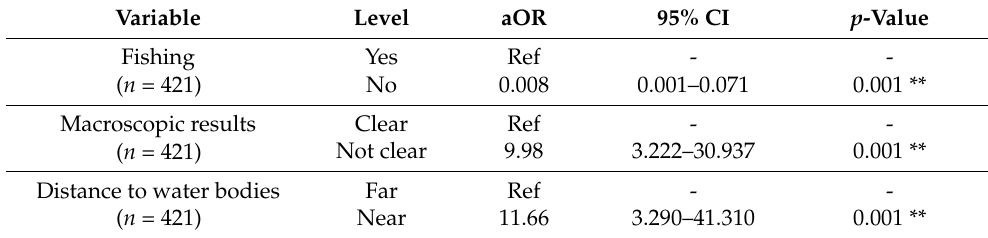
Table 5. Risk factors for Schistosomiasis.